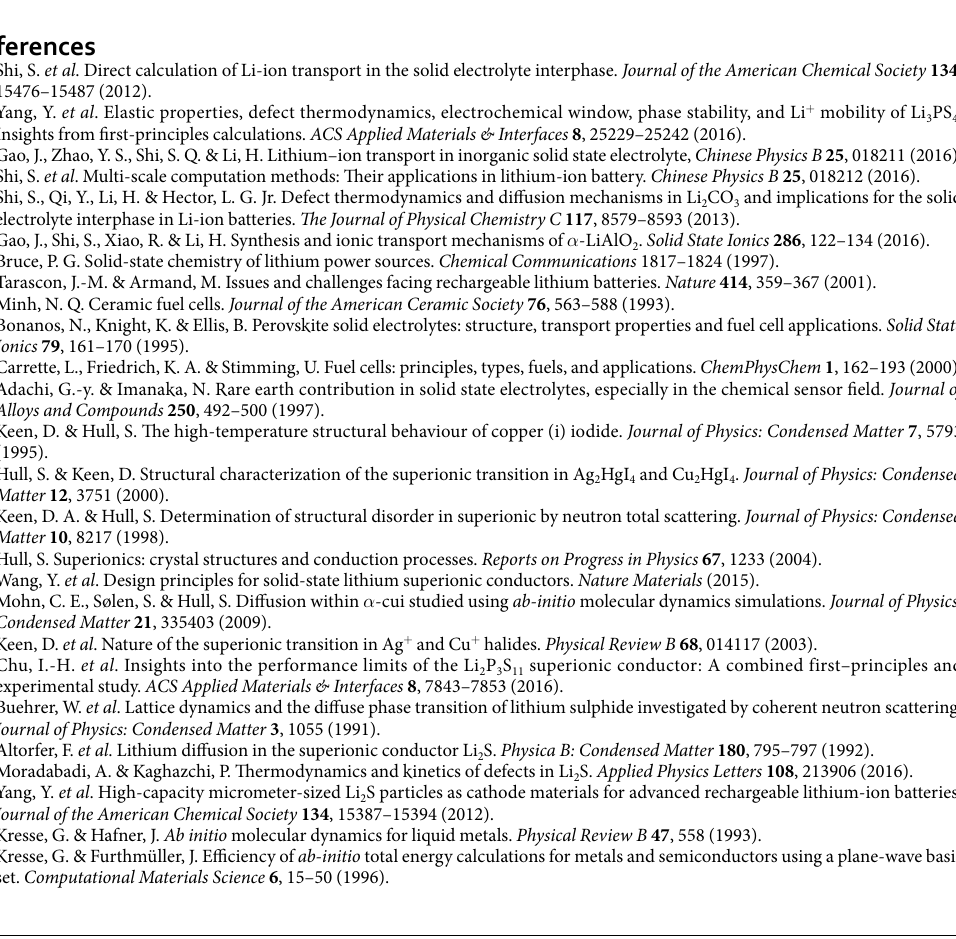
The diffusion pathway and diffusion coefficient were evaluated using the ab initio MD (AIMD) calculations (implemented in VASP). AIMD calculations were performed in the canonical (NVT) ensemble with time steps of 1 fs. Bulk Li 2 S was modelled by 2 × 2 × 2 super cells with 4 × 4 × 4 Monkhorst-Pack k -point mesh with an energy cutoff of 360 eV. Mean Square Displacements (MSD) is obtained through the fol- lowing equation: